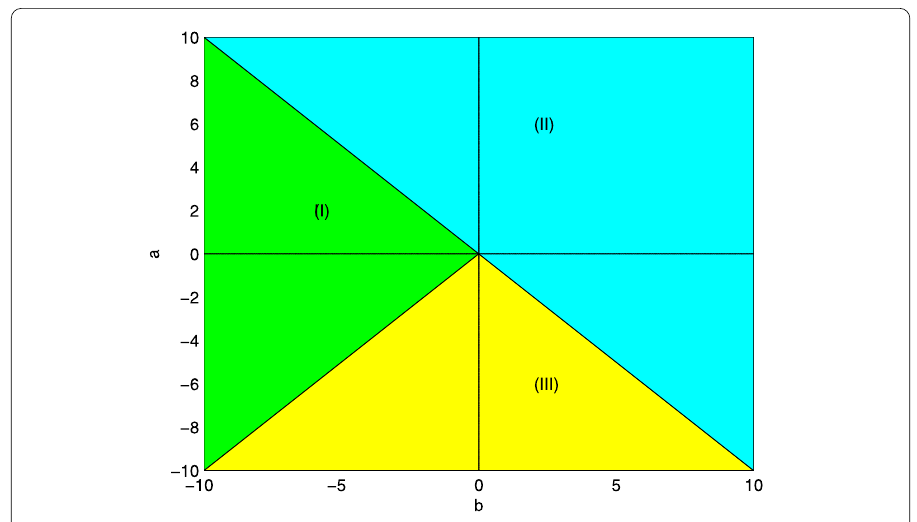
Figure 1 Stability regions of Eq. (1): (I) stable region for the delay in the interval [0, τ 1 (0)), (II) unstable region, (III) stable